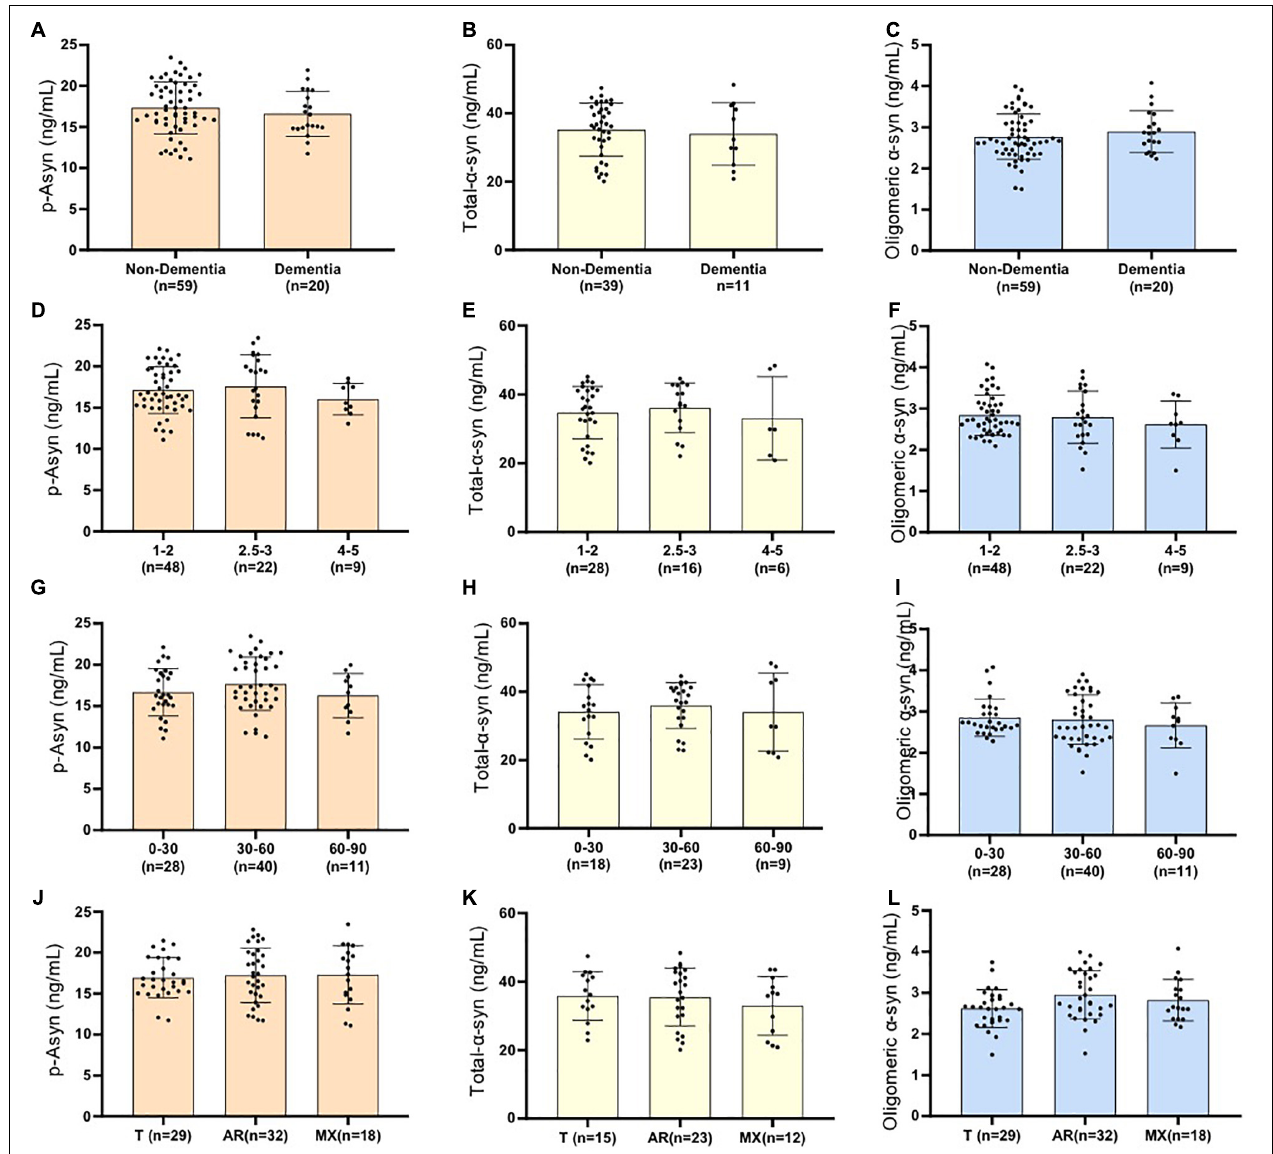
FIGURE 5 | Examined whether plasma Lewy body-associated proteins levels were correlated with disease severity in terms of either motor Hoehn–Yahr stages (A–C) , cognitive symptoms (D–F) , UPDRS scores (G–I) , and subtypes of clinical symptoms (J–L) among patients with PD ( p > 0.05, the Mann–Whitney U test and the Kruskal–Wallis test). No significant difference is presented as ns. Non-dementia in (A–C) represents PD patients without dementia; Dementia in (A–C) represents PD patients with dementia; Cognitive impairment was evaluated by MMSE (patients with MMSE no more than the cut point is defined as dementia; illiteracy at 17, primary school education at 20, high school degree and higher degree at 24); Patients with PD are divided into three groups with different motor Hoehn–Yahr stages(H–Y = 1–2, H–Y = 2.5–3, H–Y = 4–5) and different UPDRS scores(UPDRS = 0–30, UPDRS = 30–60, UPDRS>60). Using portions of the Unified Parkinson’s Disease Rating Scale, a ratio value was derived, yielding three patient subtypes: a tremor-dominant group (T), an akinetic-rigid group (AR), and a mixed group